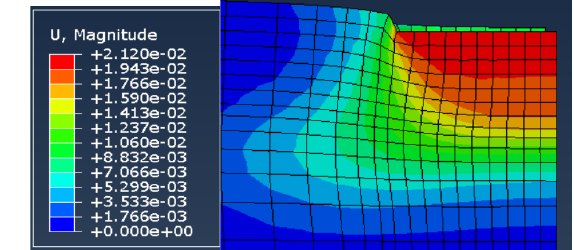
Figure 16 : Displacement contours of case 1 at h/B = 0.7 for L/B=2. Figure 17 : Displacement contours of case 8 at h/B = 0.7 for L/B=2.